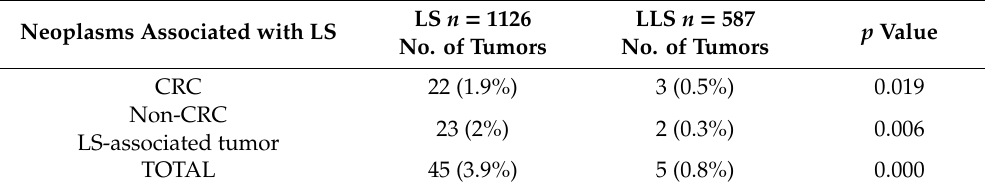
Table 4. Prospective appearance of new cases of cancer between LS patients and their FDR and LLS patients and their FDR.